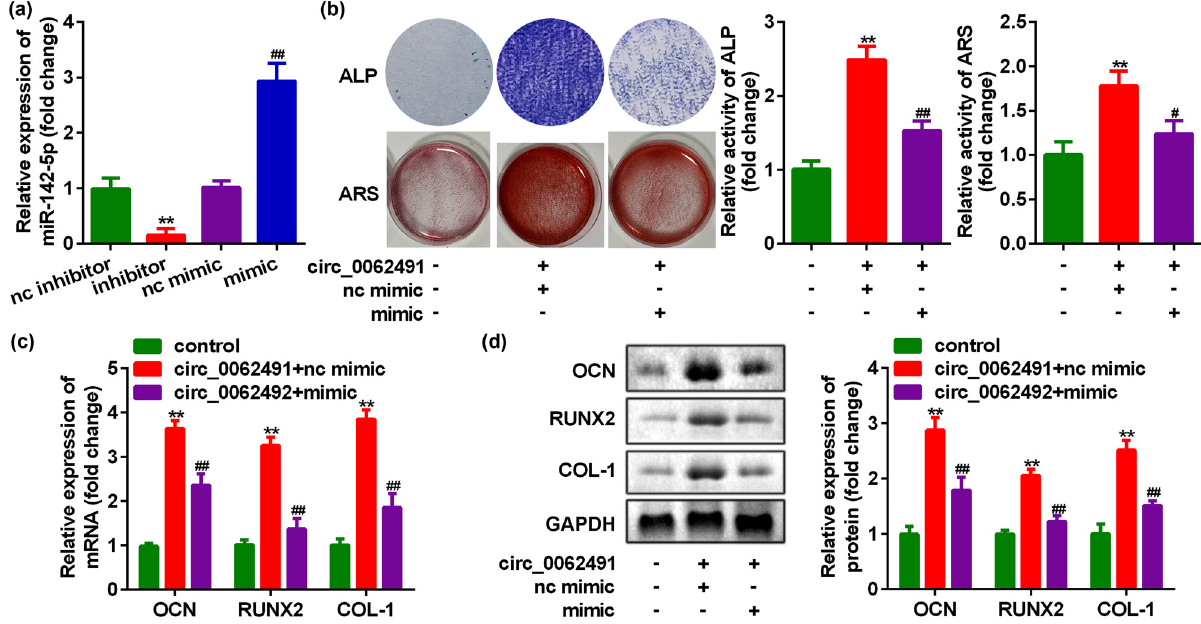
Figure 4: Overexpression of miR - 142 - 5p reversed the e ff ects of circ_0062491 on osteogenic di ff erentiation of PDLSCs. ( a ) miR - 142 - 5p expression levels were detected by qRT - PCR. ( b ) Images and quanti fi cation of ALP staining and ARS of PDLSCs transfected with circ_0062491 and miR - 142 - 5p mimic. ( c ) qRT - PCR analysis for the expression of OCN, RUNX2, and COL - 1. ( d ) Western blotting analysis for the expression of OCN, RUNX2, and COL - 1. ** p < 0.01, vs nc inhibitor and control group. # p < 0.05, ## p < 0.01, vs nc mimic and circ_0062491 + nc mimic